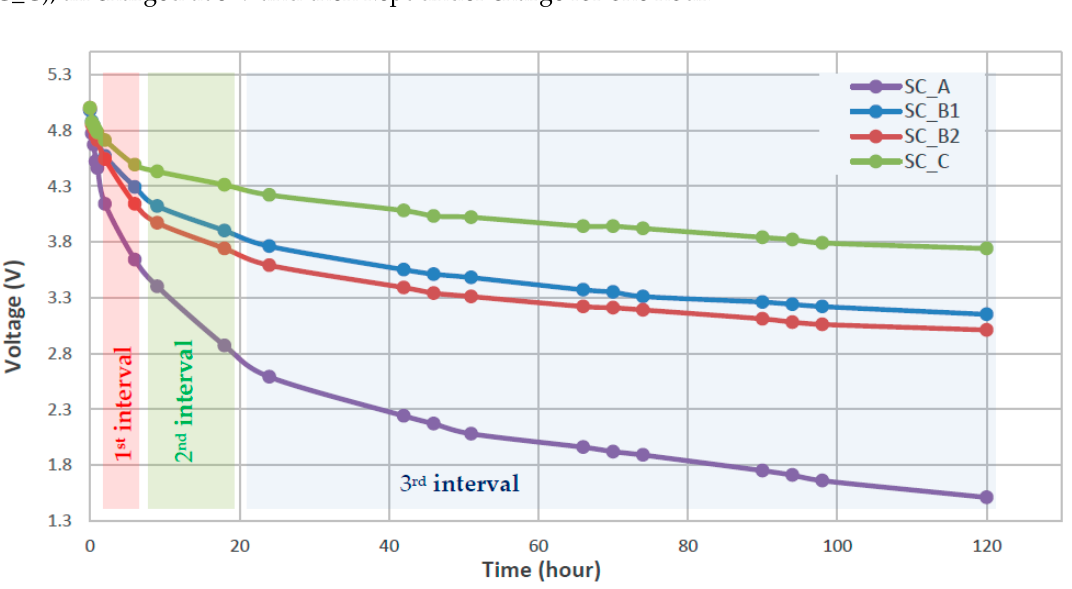
Figure 7. Self-discharge time-domain patterns for two different type-B SCs (indicated as SC_B1 and SC_B2), a type-A SC (SC_A) and a 2F type-C SC (indicated as SC_C), charged at 5 V and then kept